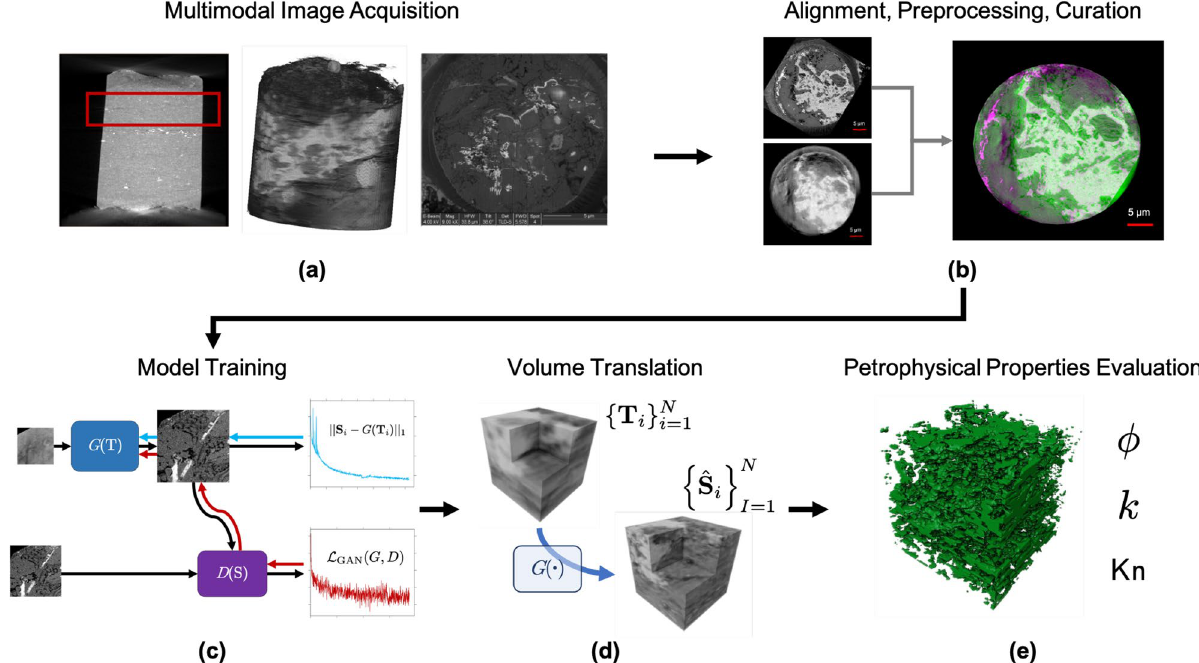
Figure 1. Multimodal image characterization workflow. ( a ) Multimodal image acquisition for a Vaca Muerta shale sample. After initial µ -CT imaging (left), a region with minimal pyrite deposits is selected and milled to a 30 µ m diameter cylindrical plug. This is imaged to produce a TXM image volume (middle). The plug is then successively focused ion beam milled and SEM imaged to create FIB-SEM image slices (right). ( b ) FIB-SEM and TXM image slices are aligned and normalized to create a paired 2D image dataset. ( c ) Image translation models are trained to predict FIB-SEM images from TXM images. These models include a continuity loss term to improve 3D volume translation when only 2D images are available. ( d ) Image volumes are predicted using the trained model. The volumes are synthesized by passing x – y image slices through the network independently to create the sequence of predicted FIB-SEM images. ( e ) Predicted FIB-SEM volumes are segmented into